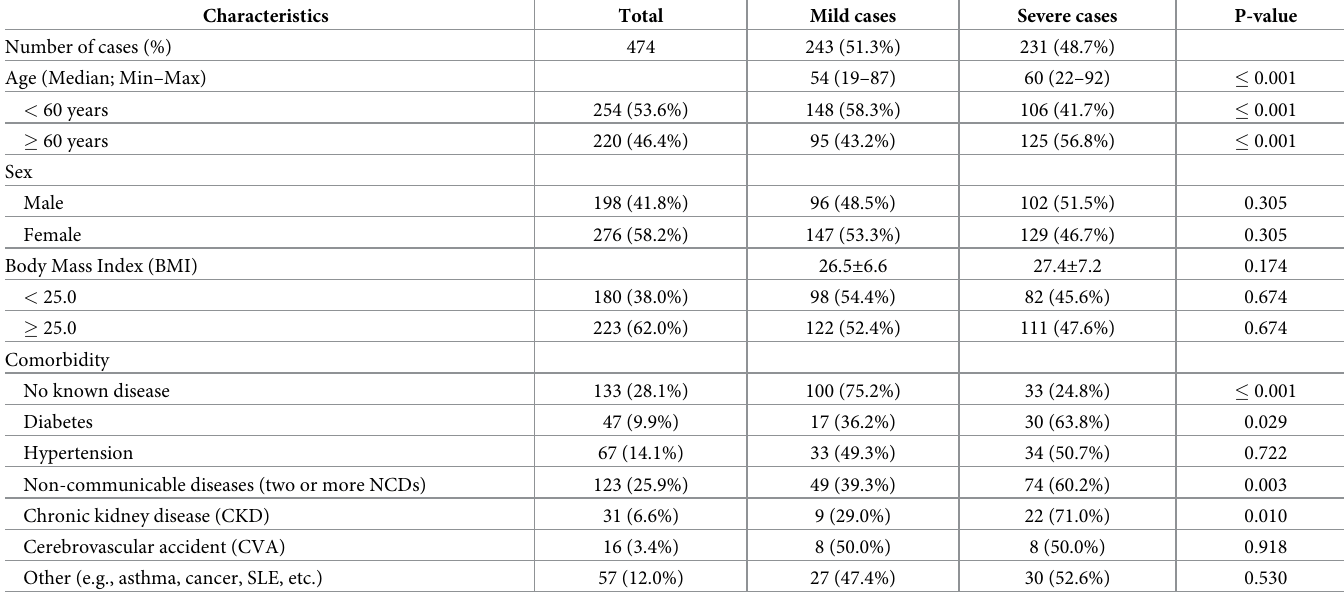
Table 1. Clinical characteristics of mild and severe COVID-19